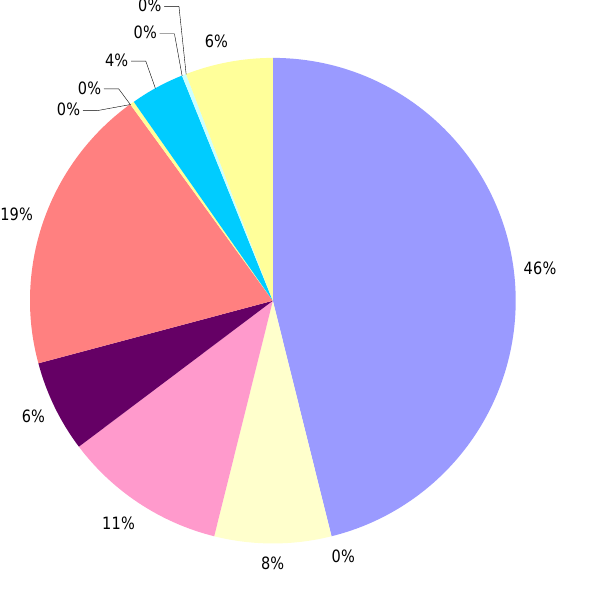
Figure 6: Capital Cost Distribution by Elemental Group